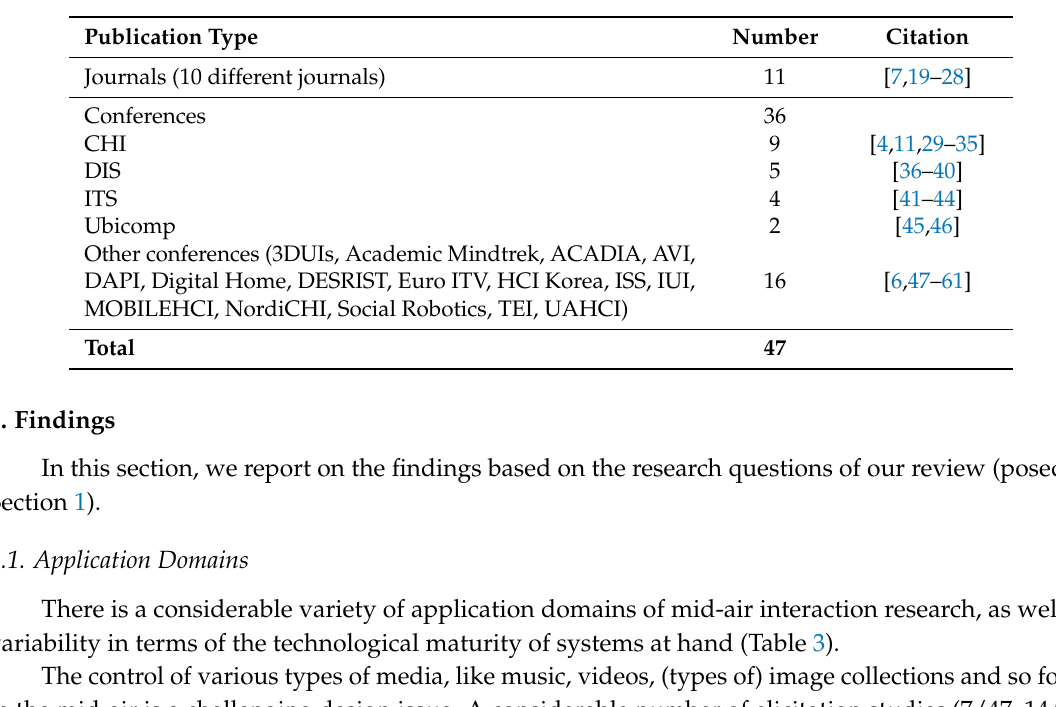
Table 2. Citations of papers selected for this review and their publication